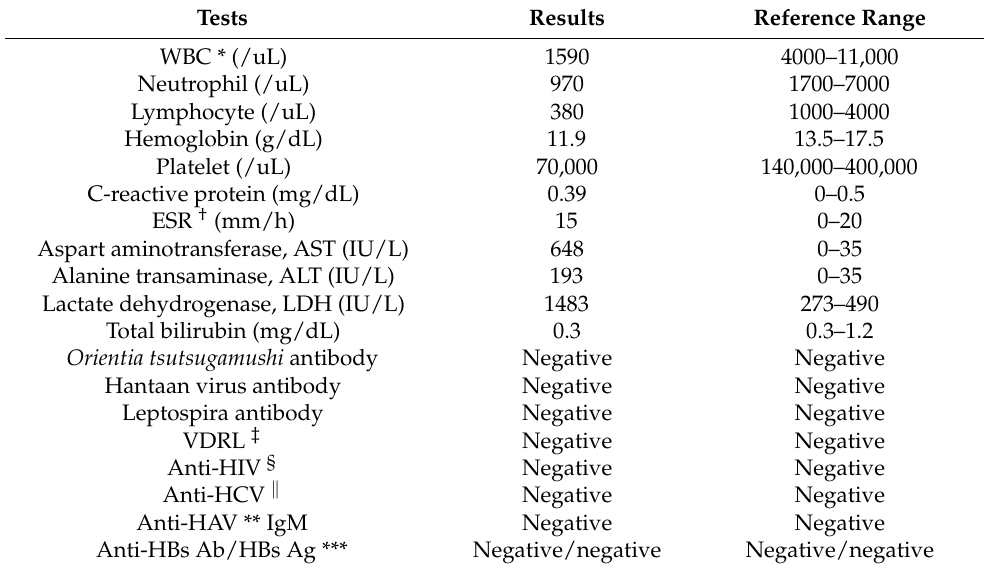
Table 1. Laboratory results of the